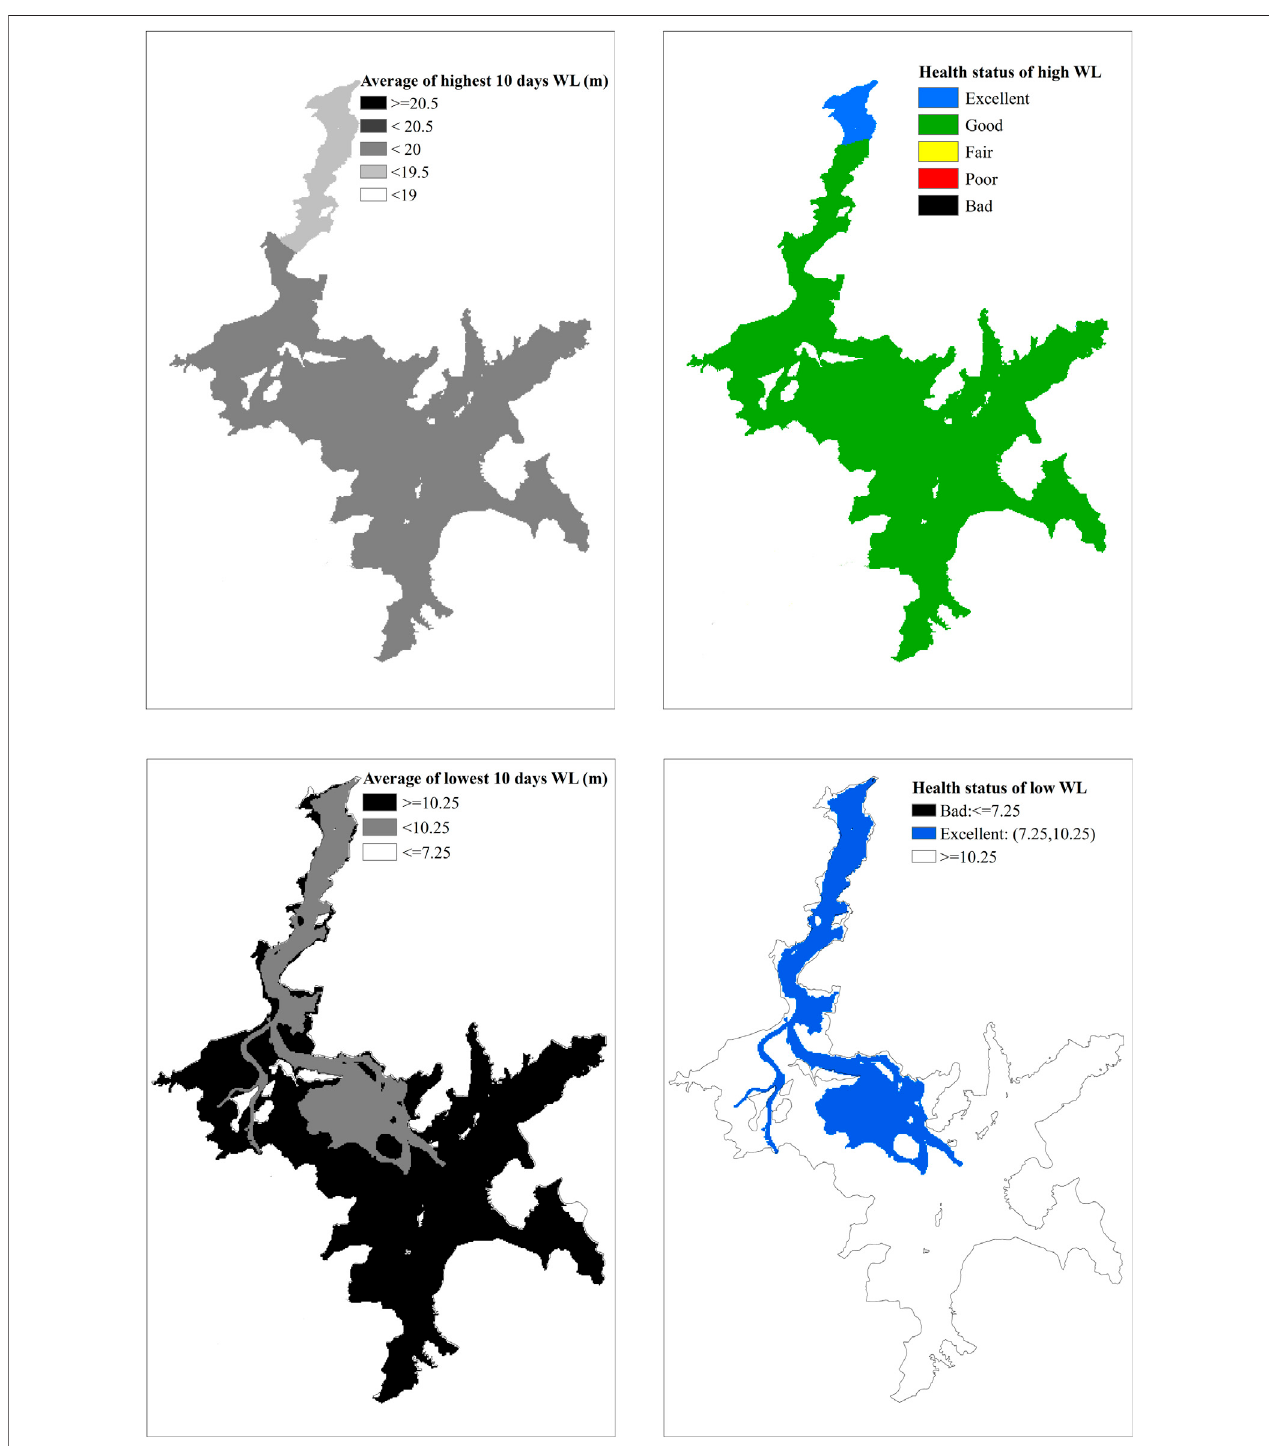
FIGURE 6 | Aquatic ecological health assessment of the water levels of Lake Poyang in 2015. (A,C) Average of highest/lowest 10 days water level, (B,D) Health status of high/low water level.